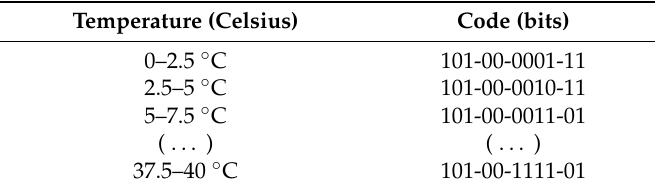
Table 1. Corresponding code from the measured temperature.